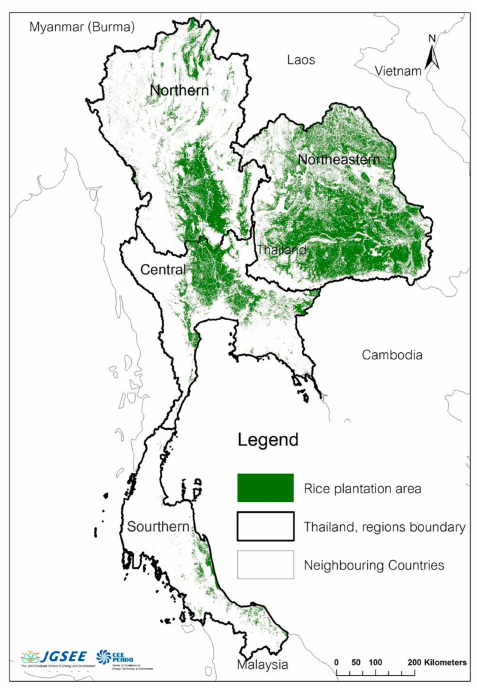
Figure 1. Spatial allocation of paddy field, modified from land use information (2014) of Land Development Department, Thailand